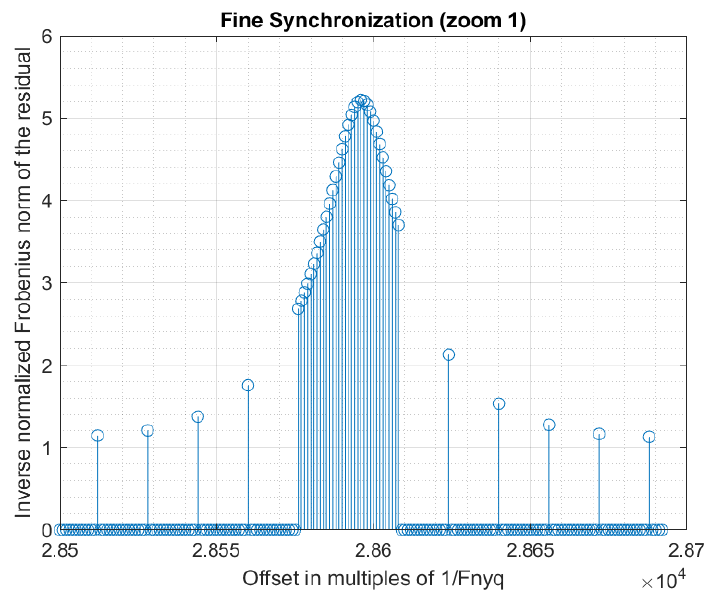
Figure 13. Synchronization (zoom 1).